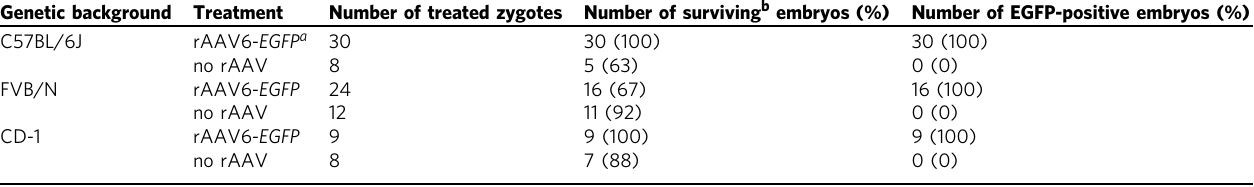
Table 2 Transduction ef fi ciency of zygotes from different strains of mice with rAAV6- EGFP Genetic background